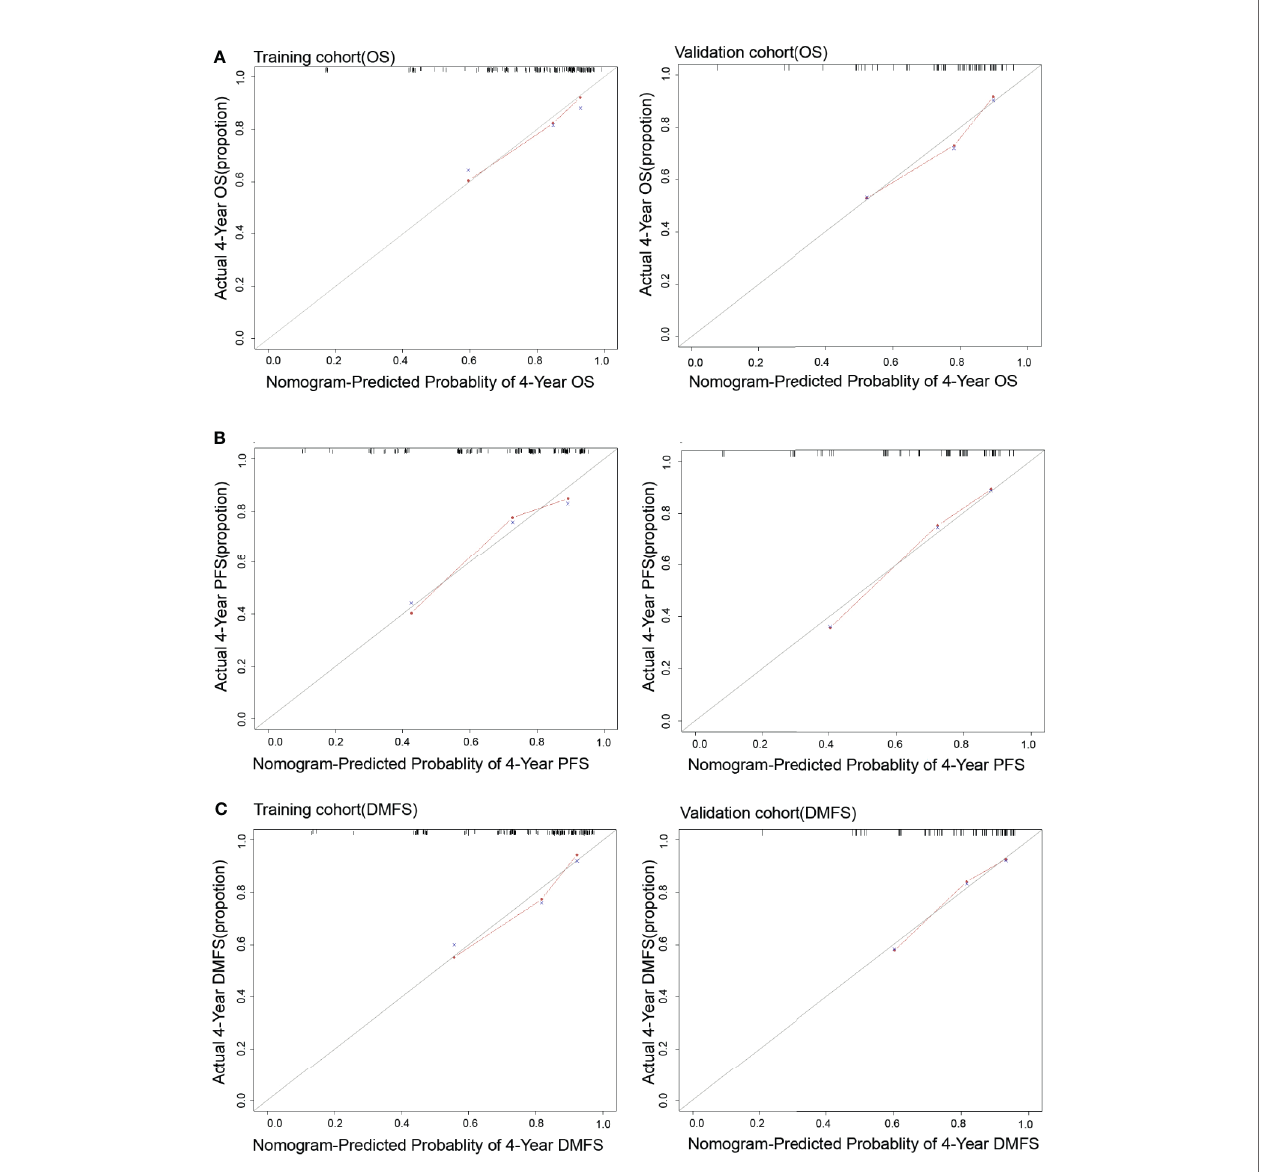
FIGURE 3 | The calibration curves of Nomograms to predict 4-year OS (A) , PFS (B) and DMFS (C) in both training and validation